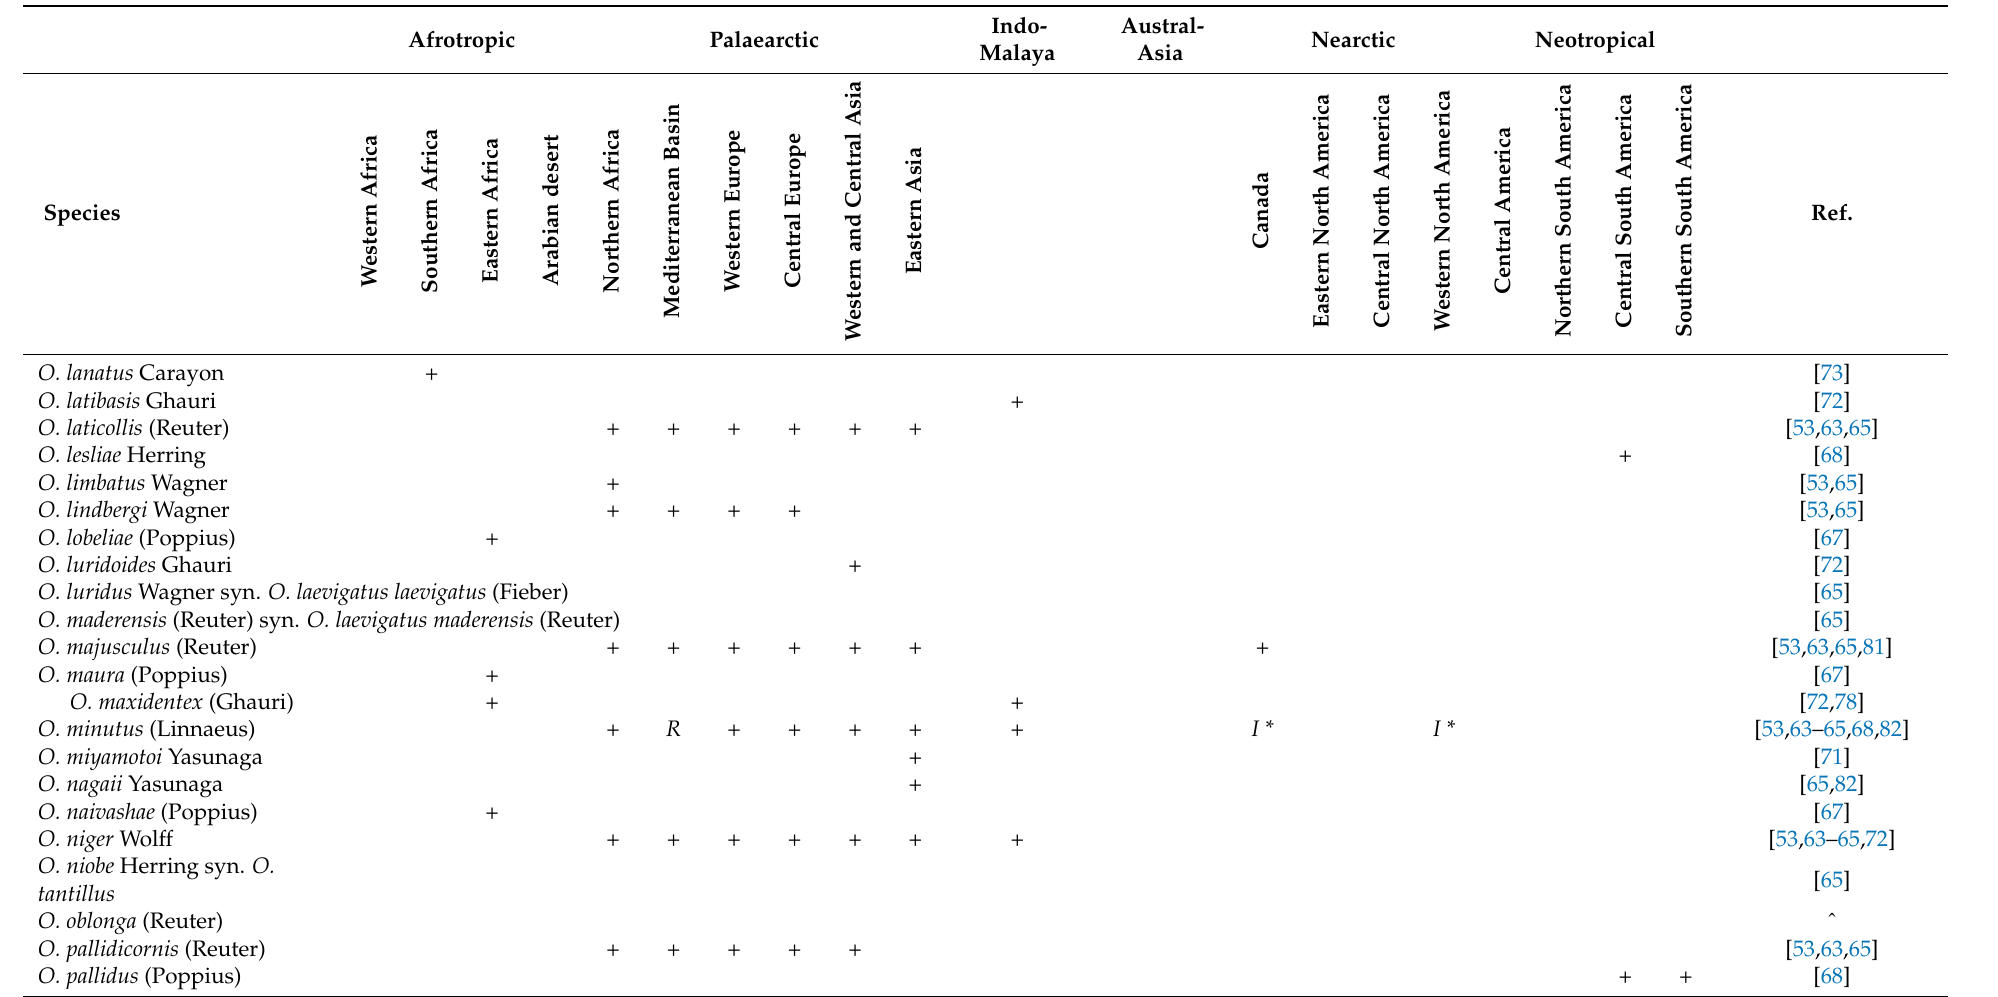
Table 2. Cont. Afrotropic Palaearctic